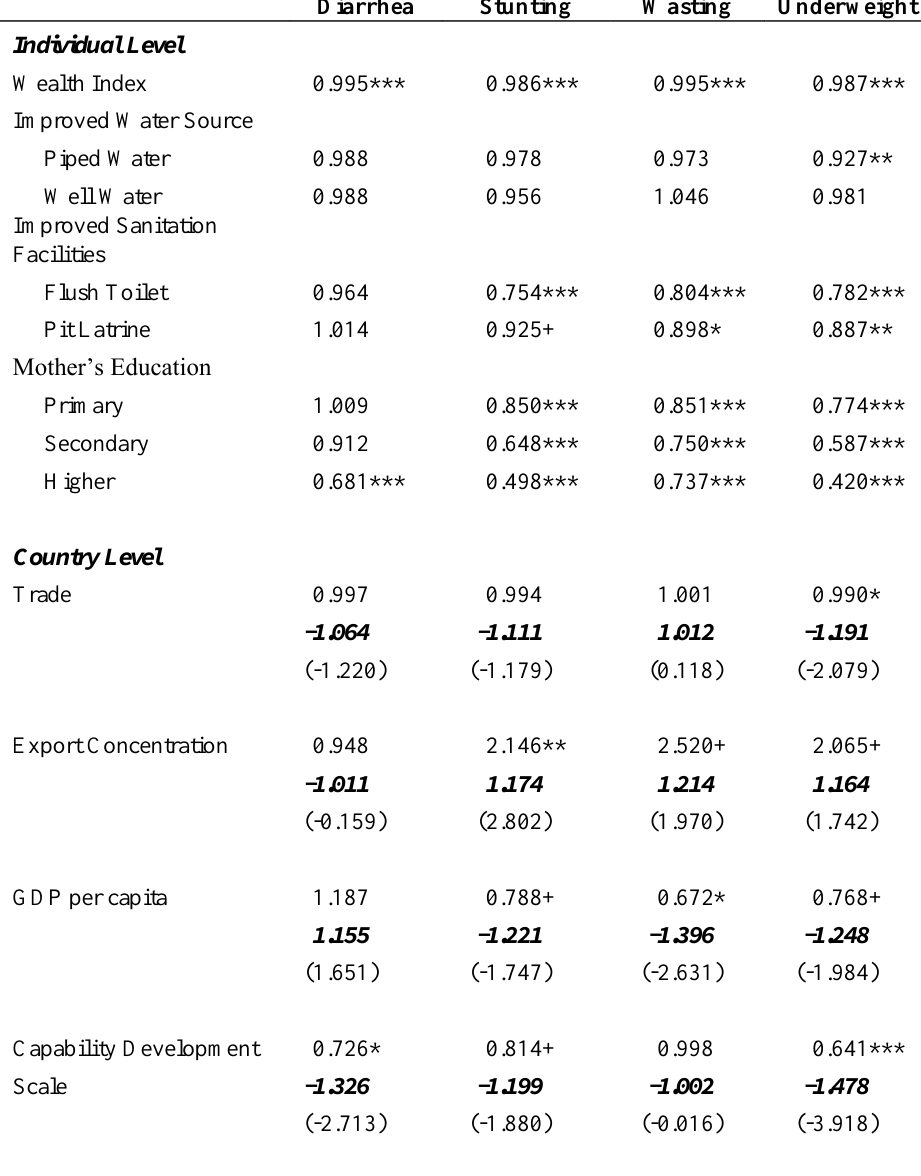
Table 4. HGLM Logit Models of Child Health on Fundamental Cause, Political Economy, and Capability Development Diarrhea Stunting